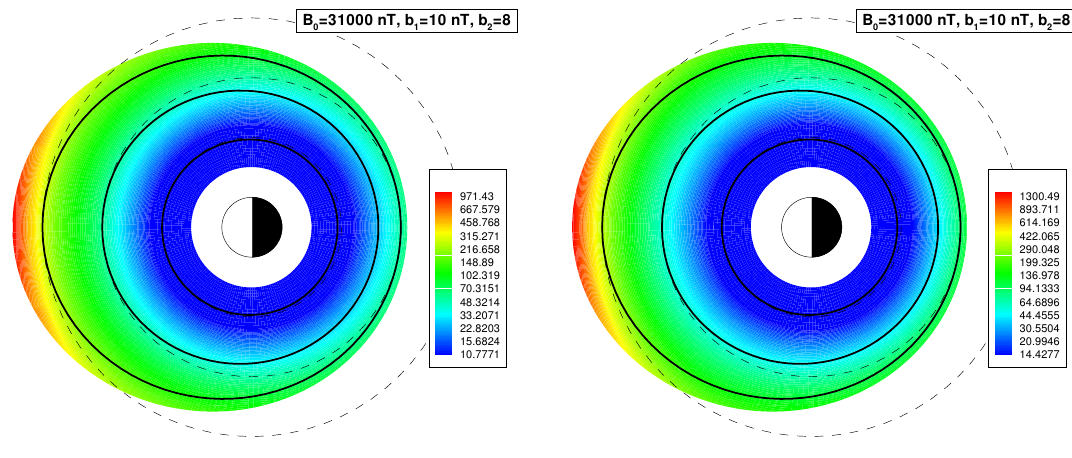
Fig. 3. Periods of the two different Alfv´en modes for B 0 = 31000nT, b 1 = 10nT b 2 = 8. Left panel: mode with radial electric field polarization at midnight; right panel – with azimuthal electric field at midnight. Thick solid lines show the contours of constant B initiated at r = 2, 4, and 6 at noon. Dashed lines are circles with r = 2, 4, and 6, respectively.